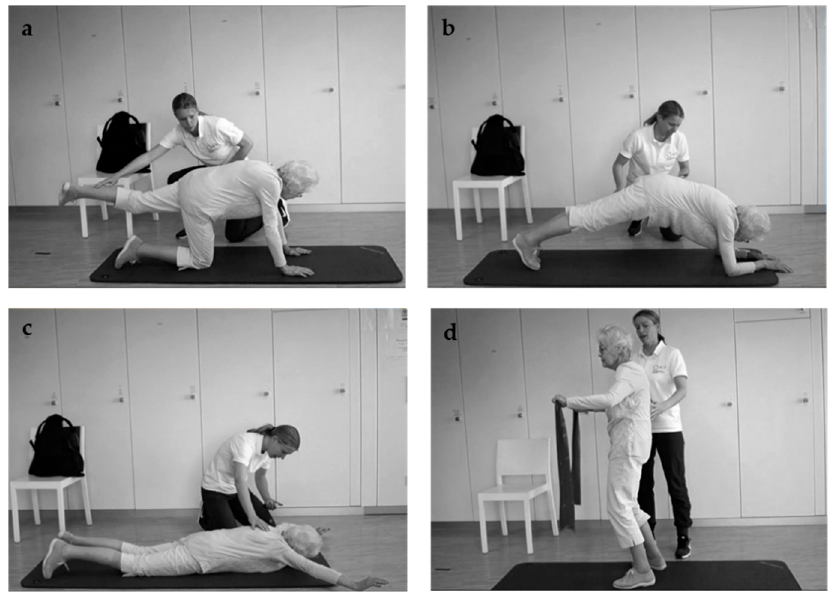
Figure 1. Exercises of the DISPO-II study: ( a ) “all fours”, ( b ) “plank”, ( c ) “swimmer”, ( d ) “shoulder blade band exercise”.